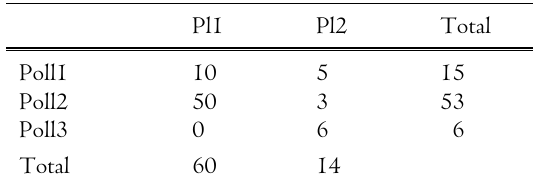
Table 2. Illustrative data set for three pollinator and two